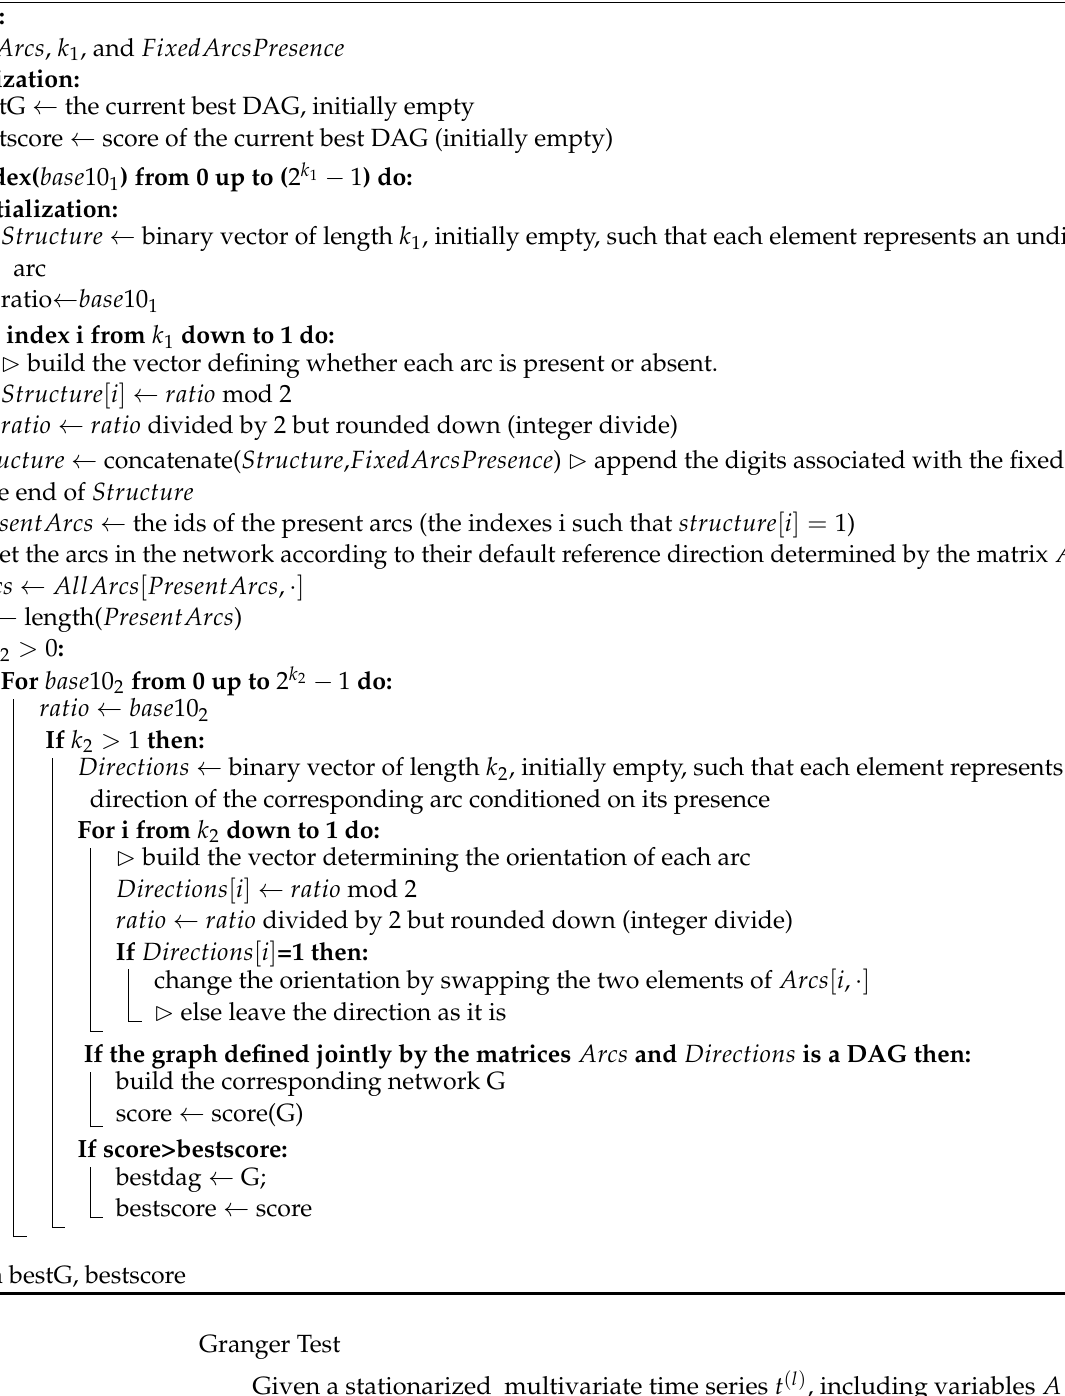
Algorithm 1 Brute force algorithm for learning the best Bayesian network